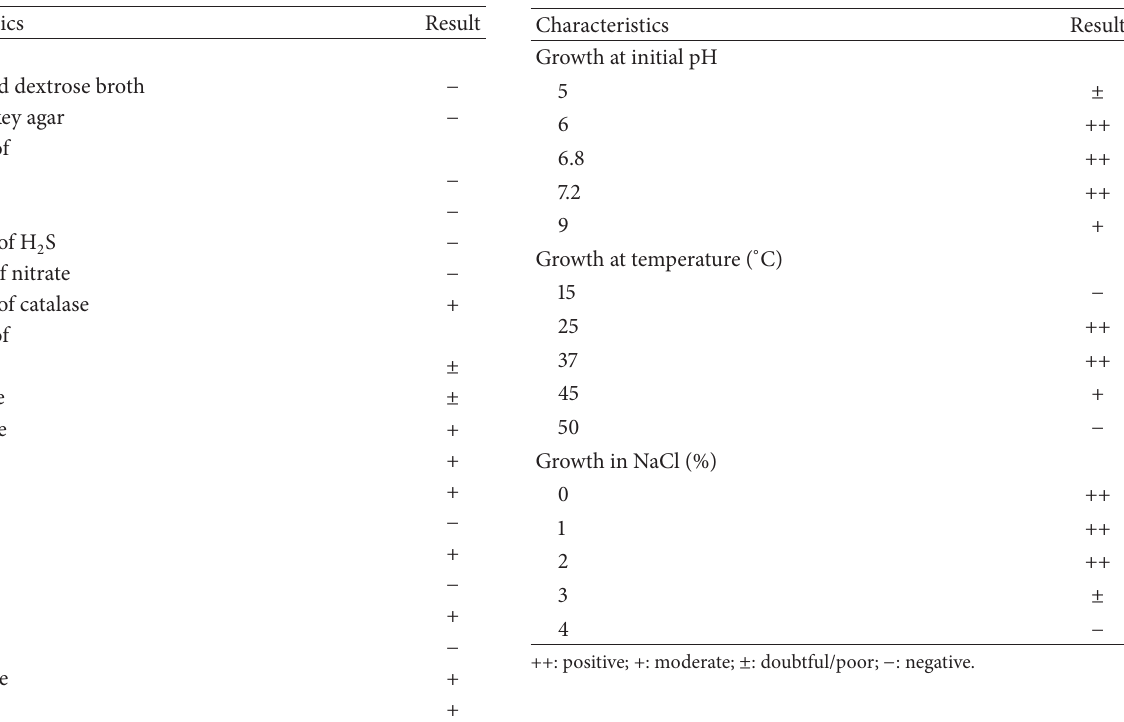
Table 2: Biochemical characteristics of strain JAJ18. Table 3: Physiological characteristics of strain